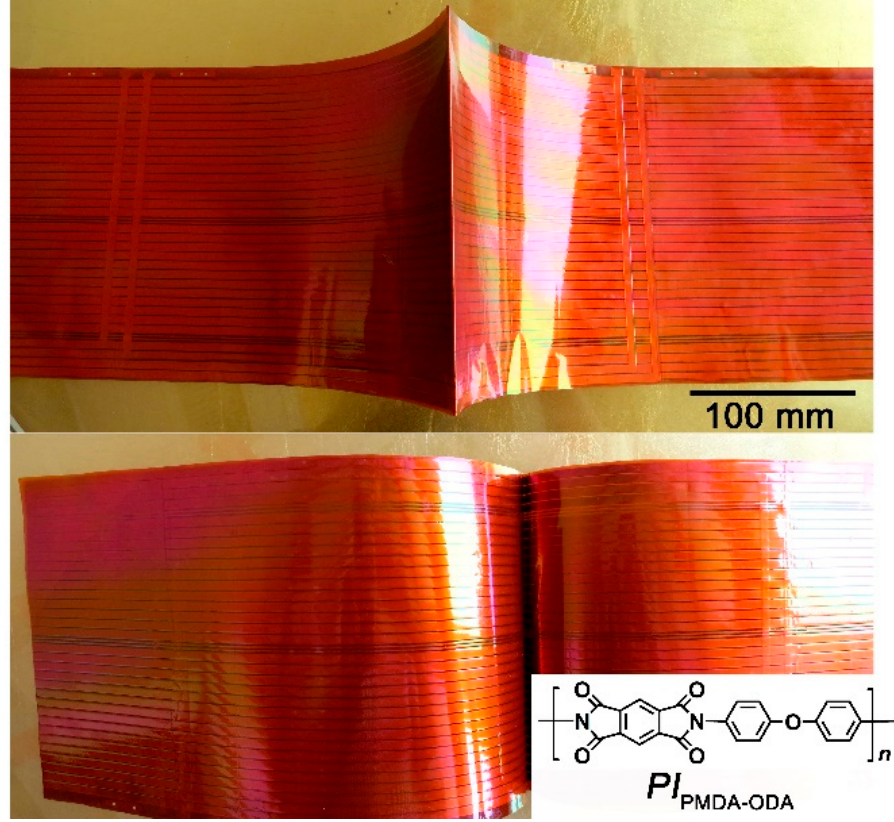
Figure 1. LEO spacecraft antennas based on PI